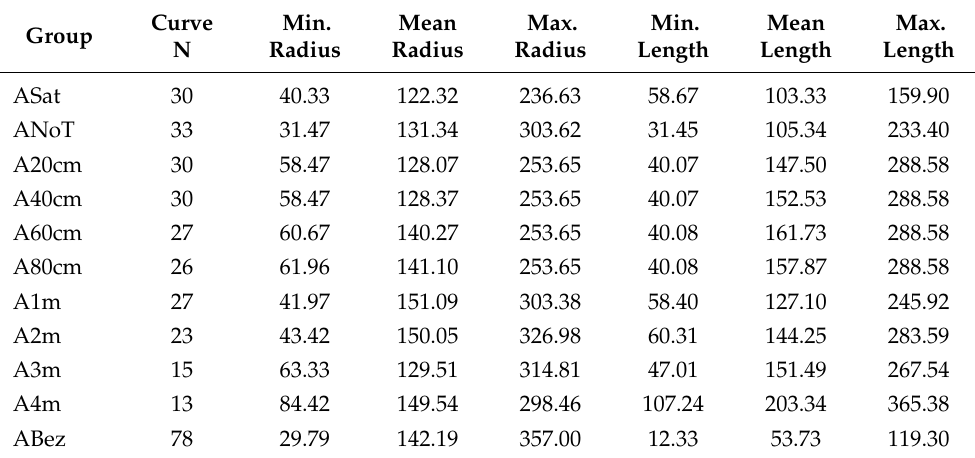
Table 1. The statistical curve data groups calculated and predicted for the rural road.